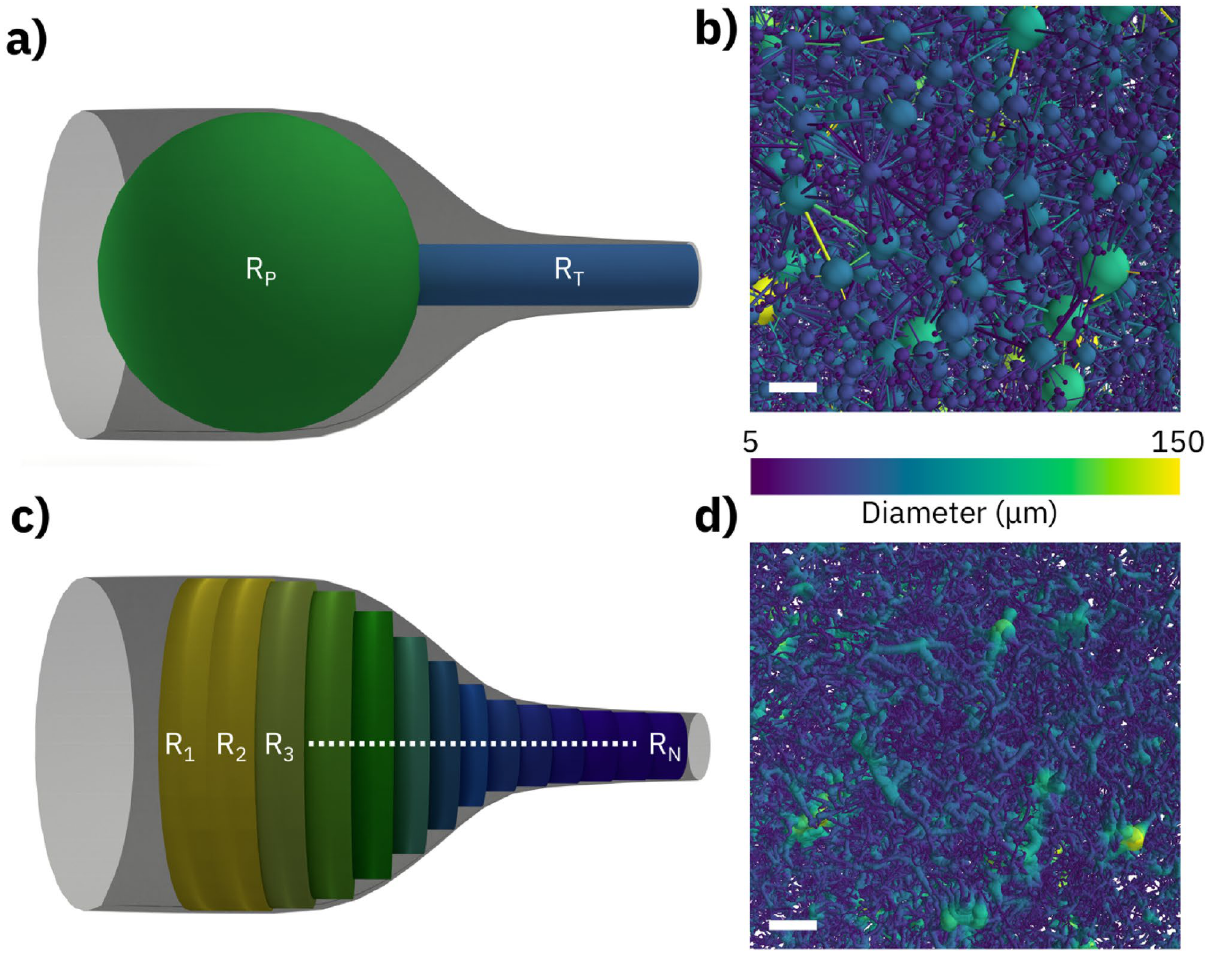
Figure 2. Visual conceptions (left) and implementation examples (right) of representative network models. ( a ) The Pore Network Model separates the pore space into spherical pores with radius R P and cylindrical throats with radius R T . ( b ) Pore Network Model representation using color-coded diameters. ( c ) The capillary network model separates the pore space into a sequence of short cylinders with gradually changing radii {R n }. ( d ) Capillary Network Model representation using color-coded diameters. The white scale bar represents 100 µm. Visual conceptions ( a , c ) created using Blender v2.92.0